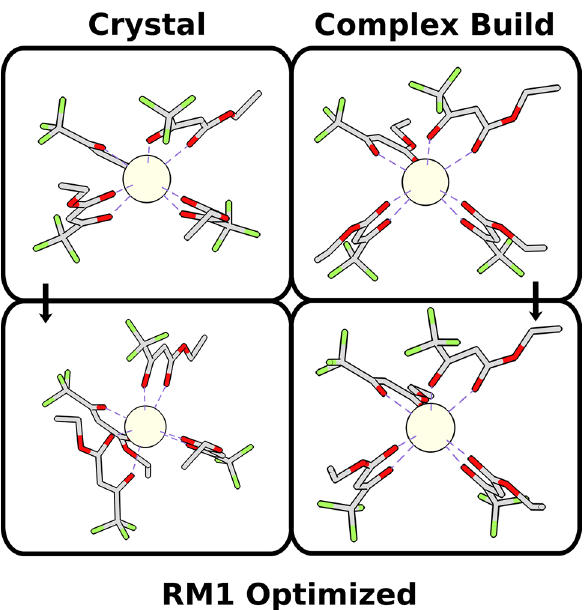
Figure 10. Ce(III) complex tetrakis(1-ethoxy-4,4,4-trifluorobutane-1,3-dionato)-cerium(iii) of stereoisomer ID 16 {[M(AB)4] SAPR-8 C2 c 2 B [1 4 3 2 8 7 5 6]} found in CSD by entry PUTQAW. On the top left, the crystallographic structure from the Cambridge Crystallographic Data Center, and, on the bottom left, the structure obtained after its RM1 optimization. On the top right, we show the structure composed by the Complex Build algorithm at the same stereoisomer configuration as that of its corresponding crystallographic one; and, on the bottom right, similarly, the structure obtained after its optimization using the RM1